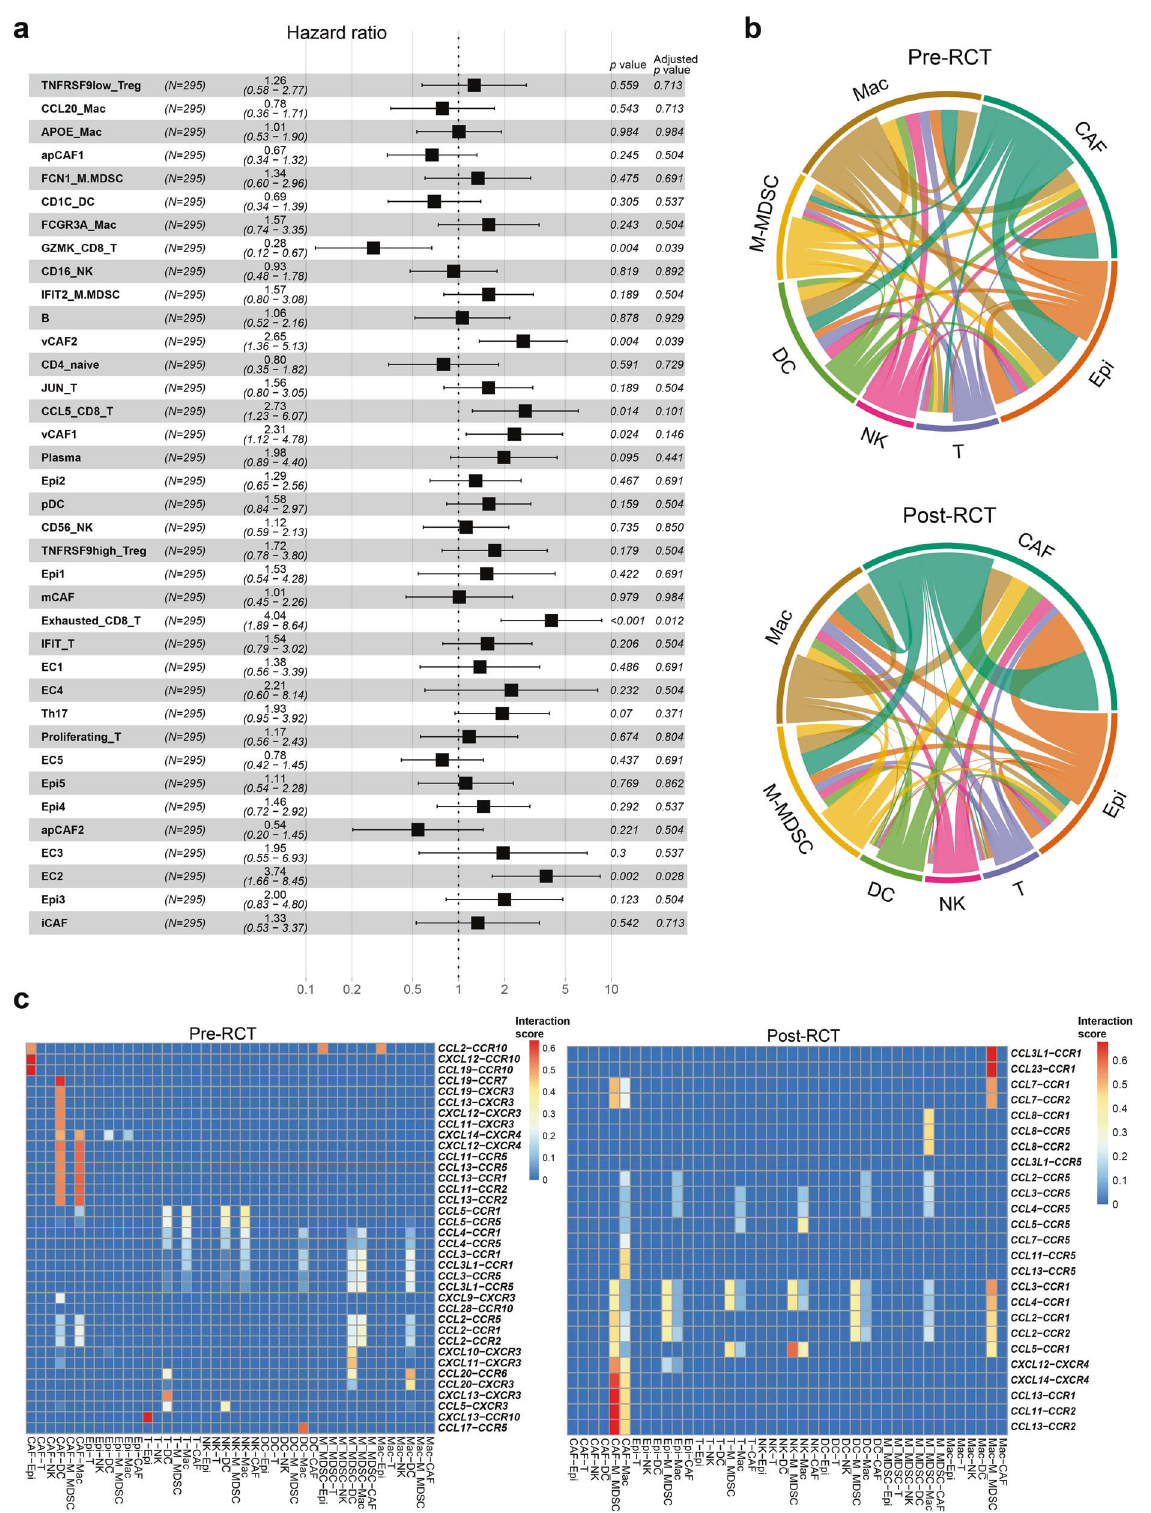
Fig. 7 Clinical role of cell subclusters and cell-cell interactions. a Correlation between the abundance of cell subclusters (CIBERSORTx analysis) and patient survival in 295 TCGA bulk RNA-seq data of CC samples (Cox regression analysis). Adjusted p values were obtained using Benjamini & Hochberg adjustment method to control the false discovery rate for multiple comparisons. b Circos plot showing the cell-cell interactions in cell clusters pre- (top panel) and post-RCT (bottom panel). The thickness of each string indicates the number of different interaction pairs colored by cell clusters. c Summary of chemokine ligand-receptor interactions between cell clusters in pre-RCT (left panel) and post-RCT samples (right panel)